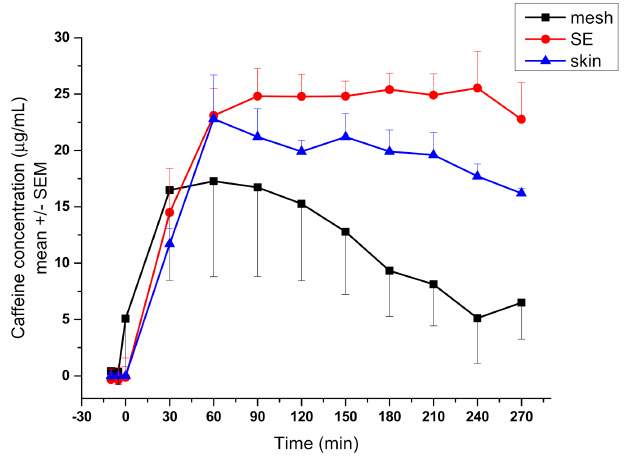
Figure 6. Transdermal transport measurements using skin equivalent (SE) and human skin. Caffeine concentration in the collected fractions was measured by spectrophotometry and is shown as a function of time [58]. The difference between concentration readings from the marked mesh-only and SE samples is significant ( p = 1.2 × 10 − 7 , n = 12 in each